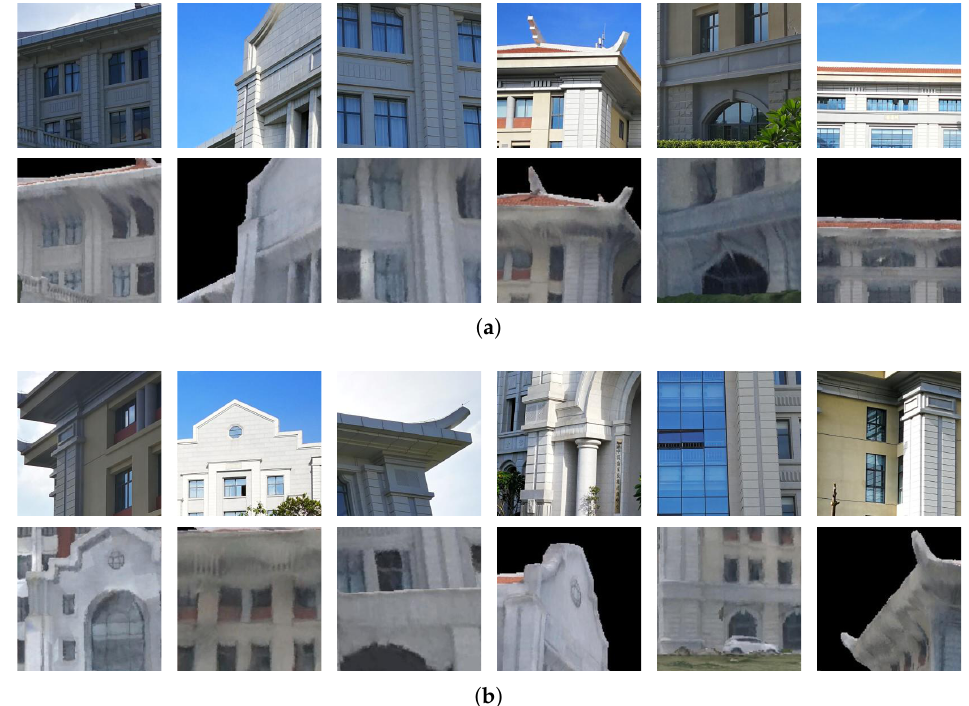
Figure 8. Several samples of collected cross-domain image patch pairs. The first row are the ground camera image patches, the second row are the rendered image patches. ( a ) Matching patch pairs of ground cameara images and rendered images. ( b ) Non-matching patch pairs of ground cameara images and rendered